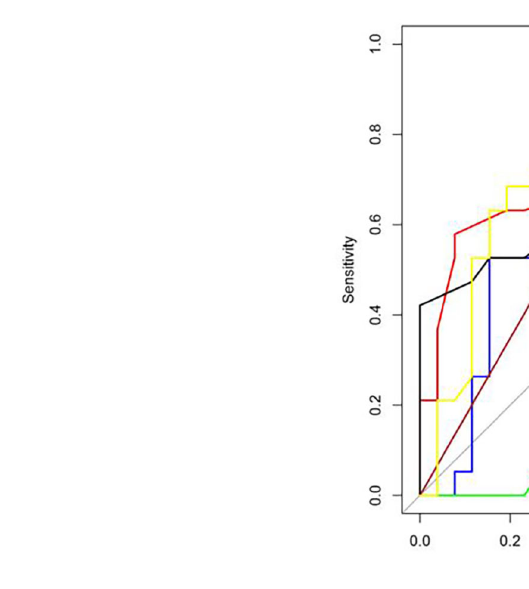
FIGURE 3 ROC curve was used to evaluate the predicting factors that in fl uences the effect of IST at 12 months, ARC at 6 months after IST with AUC more than